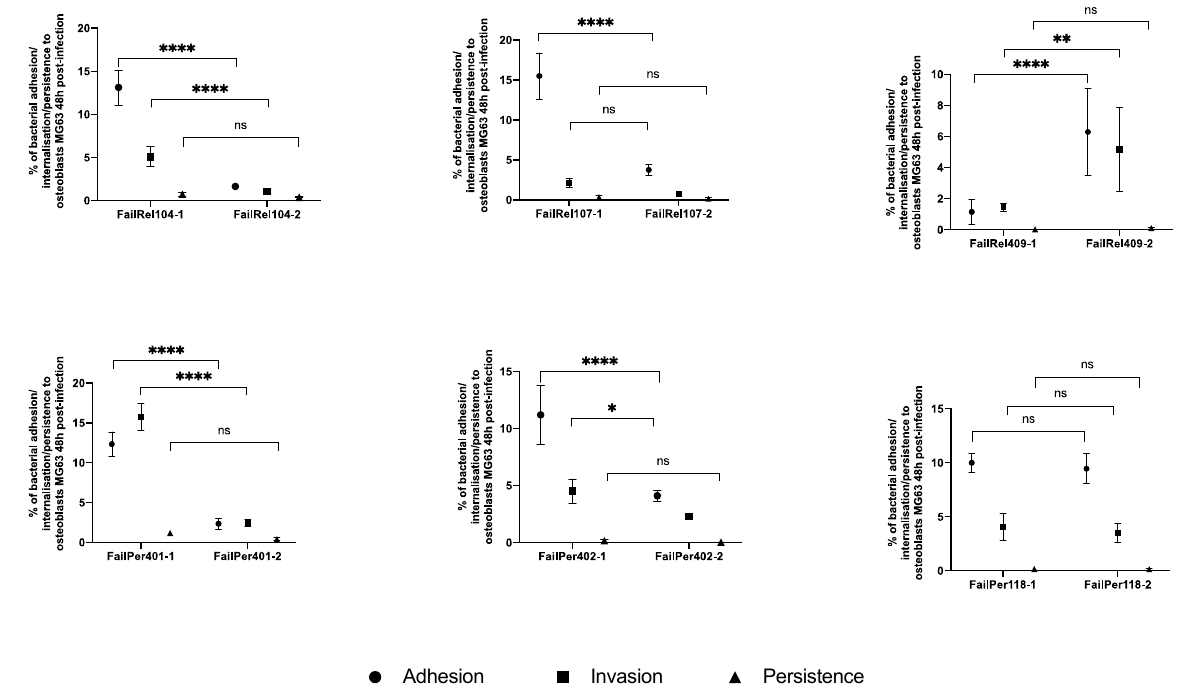
Figure 3. Comparison of the adhesion, invasion and persistence capacities between initial and second isolates of persistent-and relapsing-PJI cases recovered from the same patient. Results represent means ± standard deviation of experiments conducted in triplicate. The statistical analyses were performed by using two-way ANOVA (* p < 0.05; ** p < 0.01; **** p < 0.0001). ns: non-significant (i.e., p ≥ 0.05).